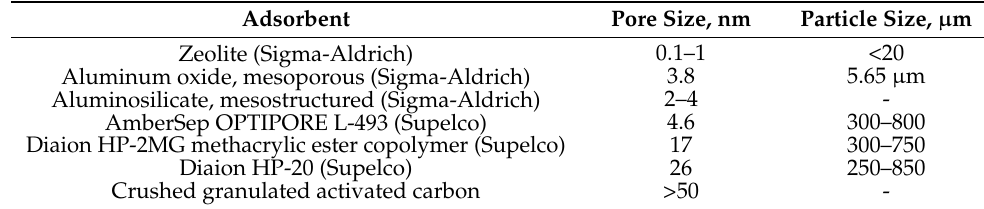
Table 1. Adsorbents used in the study and their characteristics. Adsorbent Pore Size, nm Particle Size, µ